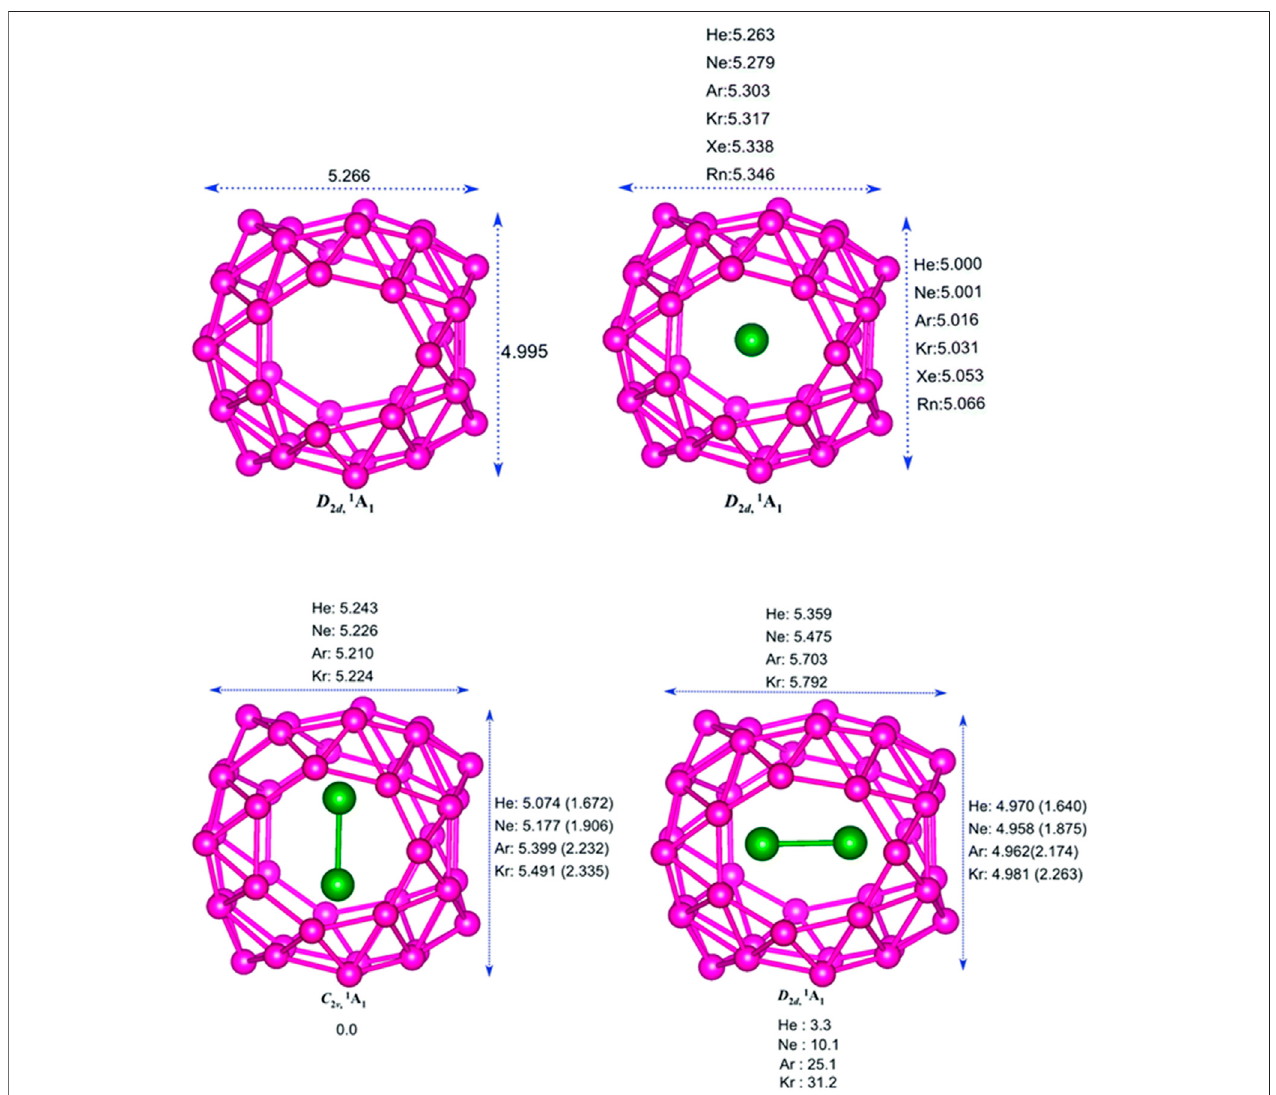
FIGURE 5 | Optimized structures of B 40 , Ng@B 40 , C 2v , and D 2d isomers of Ng 2 @B 40 optimized at the ω B97X-D/def2-TZVP level. (Adapted from Pan et al., 2018 with permission from the PCCP Owner Societies.).